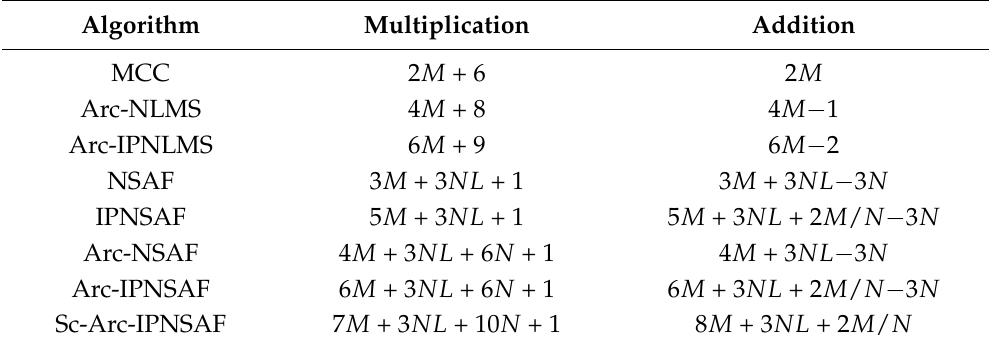
Table 1. Computational complexity of updating w ( k ) for one iteration. MCC, maximum correntropy criterion; IPNLMS, improved proportionate normalized least mean squares; Sc, sparsity control.